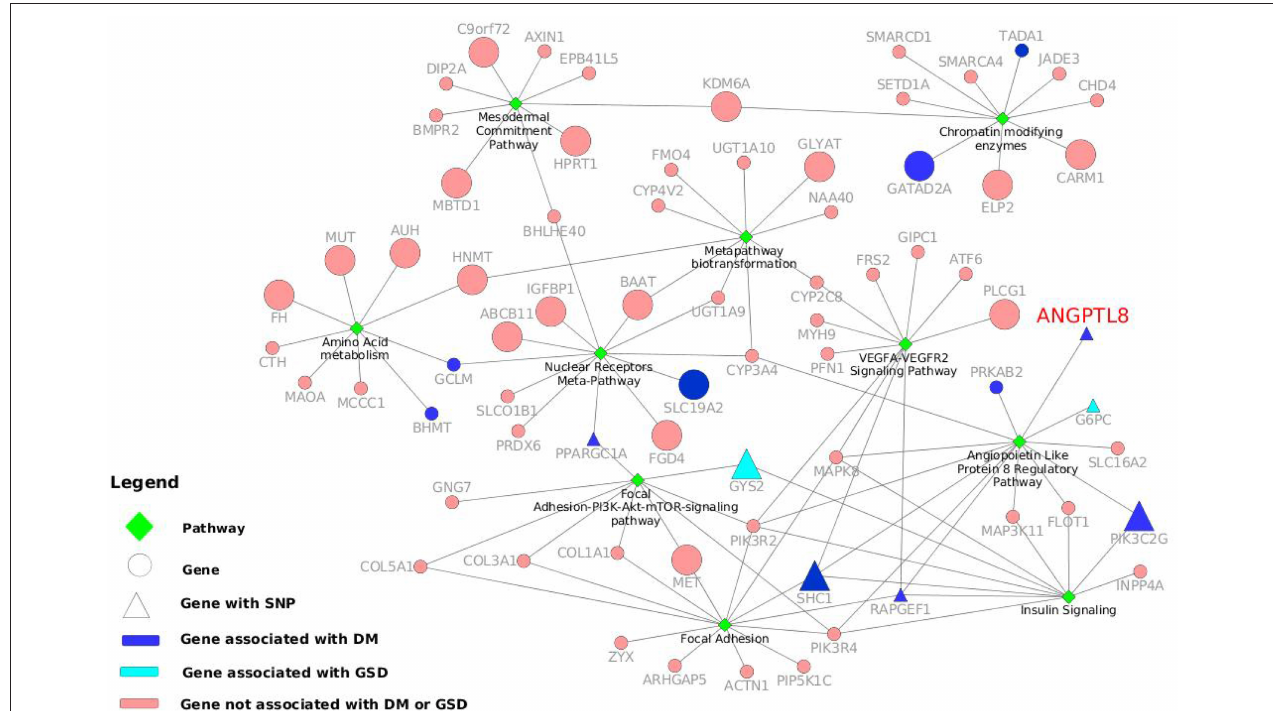
FIGURE 3 | Gene-pathway network with information of genes and variants associated to DM and other metabolic disorders. The top ten pathways identified with maximum number of genes in WikiPathways human curated collection are illustrated as green diamonds. The pathways are connected with seventy two genes (circles and triangles) and the size of the gene nodes indicate that the gene is either a hub gene (large nodes) or not (small nodes) in the co-expression network of ANGPTL8. The dark blue nodes indicate genes associated with DM. The aqua color nodes are the genes associated with GSD1. The triangle shapes represent the genes with a SNPs associated to DM or other metabolic disorders. ANGPTL8 gene is highlighted in